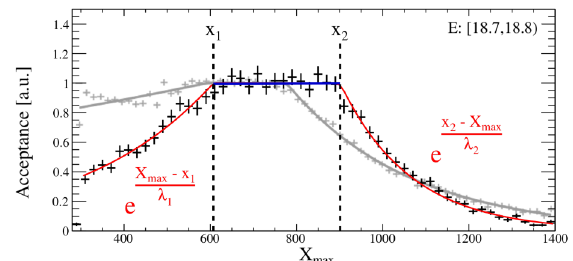
Figure 1: FD X max acceptance before (gray) and after (black) FidFoV cuts. A 4-variable parameterization of the post-FidFoV acceptance is shown in red. The range of X max values with unbiased sampling is shown in